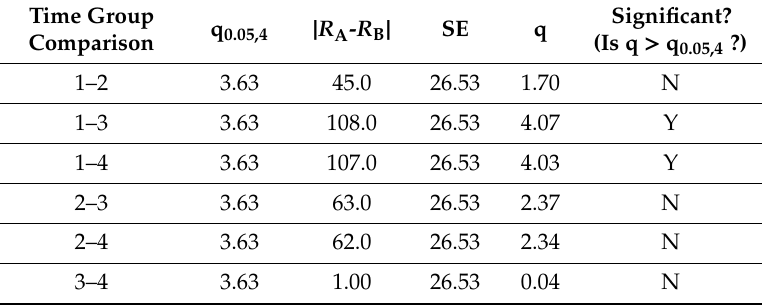
Table 1. Critical values (q 0.05, 4 ), absolute di ff erence between mean of ranks ( | R A - R B | ), standard errors (SE), and test statistics (q) to assess statistical significance, at α = 0.05 of any di ff erences among the four time groups (1 = 1984–1991, 2 = 1992–1999, 3 = 2000–2007, and 4 = 2008–2015) for total annual area of CESF patches > 400 ha using the Nemenyi non-parametric test for multiple comparisons between groups with an equal sample size (n = 8 years for each time group). The statistical significance of the levels of q are shown as “Y” (significant) or “N” (not